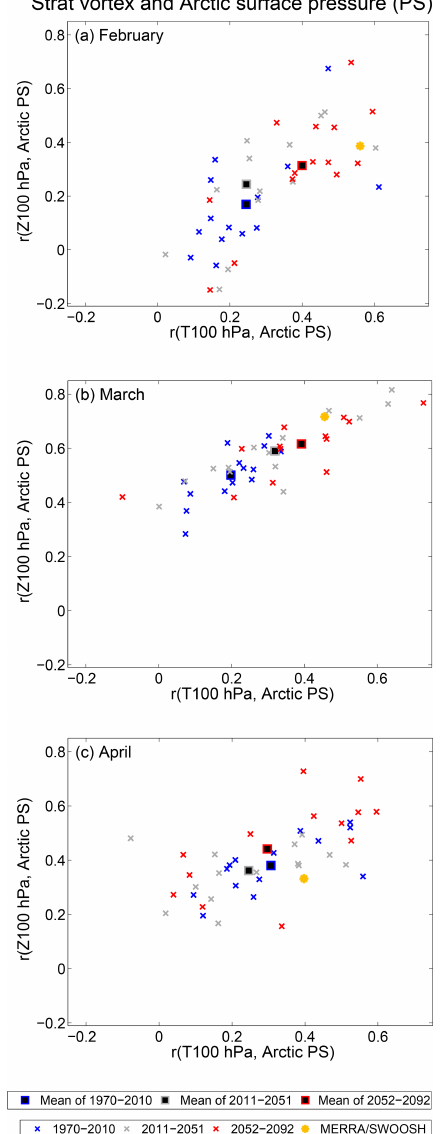
Figure 7. Correlation between stratospheric variability and polar cap surface pressure (PS), with simulations conducted during the period 1970–2010, 2011–2051, and 2052–2092 in separate colors in (a) February, (b) March, and (c) April. For the x axis, the corre- lation is conducted with polar cap temperature at 100hPa, and for the y axis, the correlation is conducted with polar cap geopotential height at